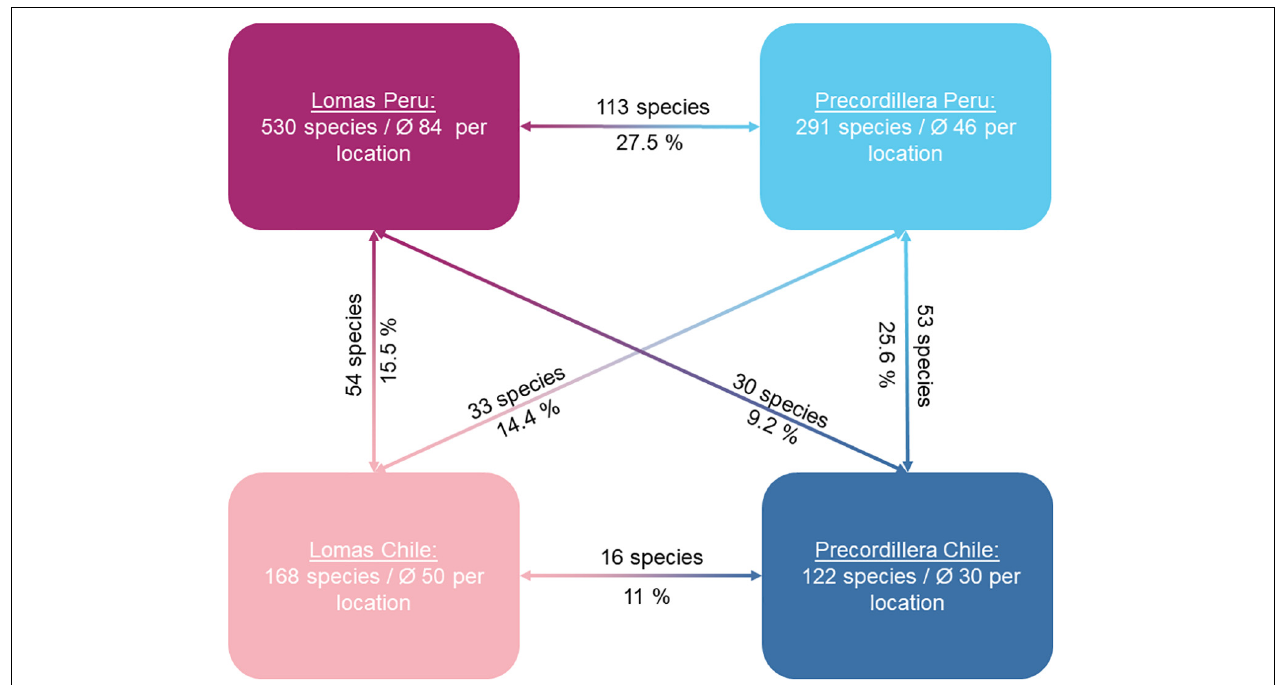
FIGURE 4 | Constellation diagram of clusters indicating total species number per cluster, average species number per location per cluster and overlap of species between clusters (Sørensen Index shown as percent). Pairwise similarity between clusters is highest for the lomas Peru and precordillera Peru cluster while the lomas Peru cluster and precordillera Chile cluster show the lowest similarity. Low similarity between the lomas Peru and lomas Chile cluster is in contrast to higher affinities between the both precordillera